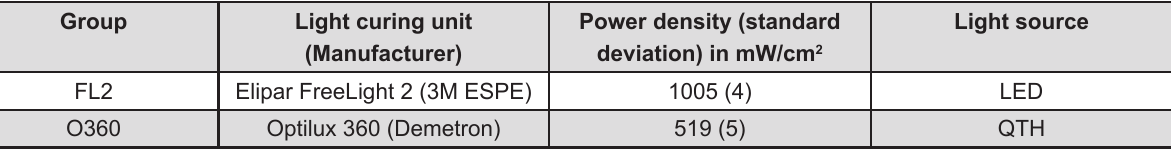
The power density was measured with a hand-held dental radiometer (Cure Rite, Kerr, Milford, MA, USA, Figure 1- Description of the light curing units used in this study